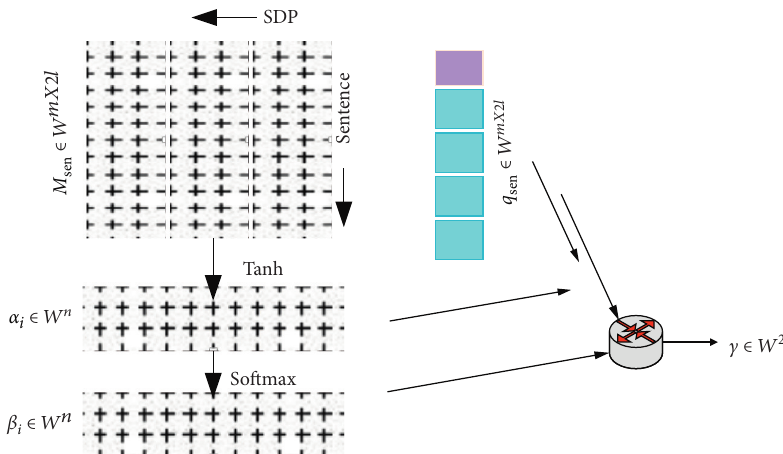
Figure 3: Schematic diagram of the attention mechanism used in this